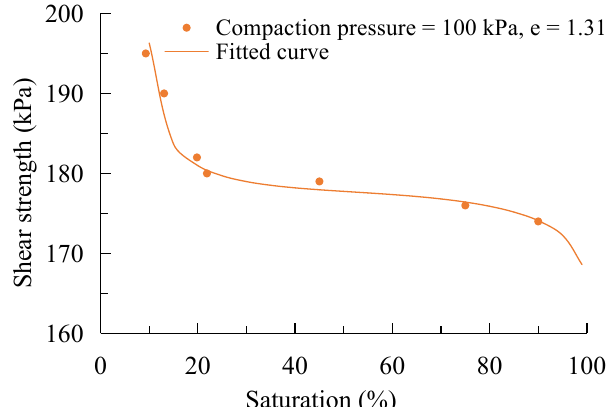
Figure 20. Calculated results on the shear strength of the compaction pressure for 100 kPa.